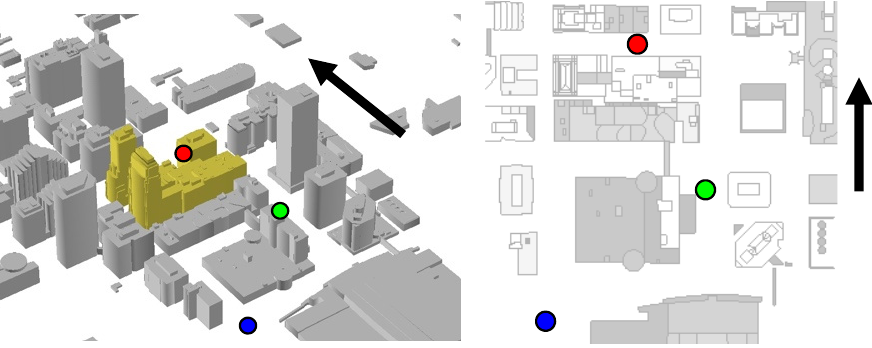
Figure 6. SF 6 release locations in the Oklahoma City central business district during Joint Urban 2003 ( ● Park Avenue, ● Westin, and ● Botanical). The northward direction is indicated by the black